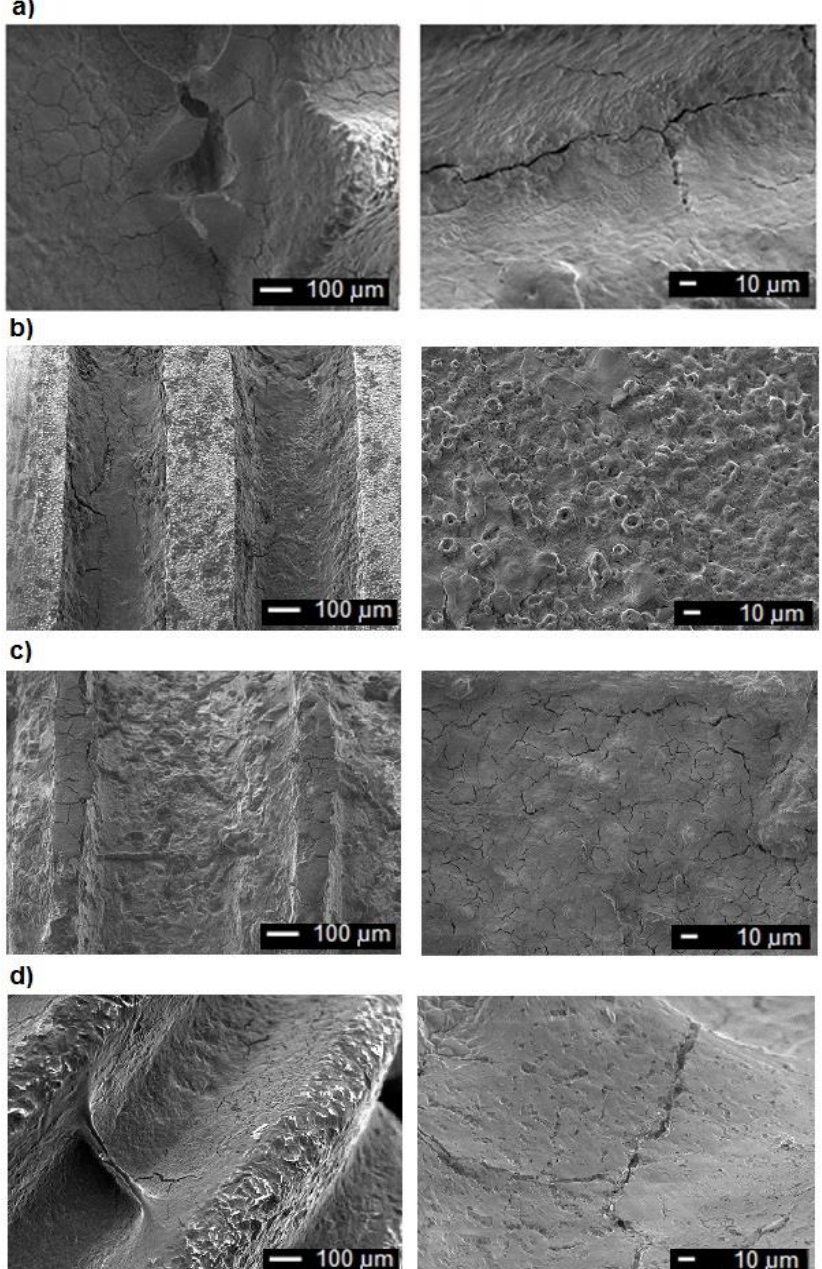
Figure 3. Surfaces of used dental implants: ( a ) A company; ( b ) B company; ( c ) C company; ( d ) D company. SEM.